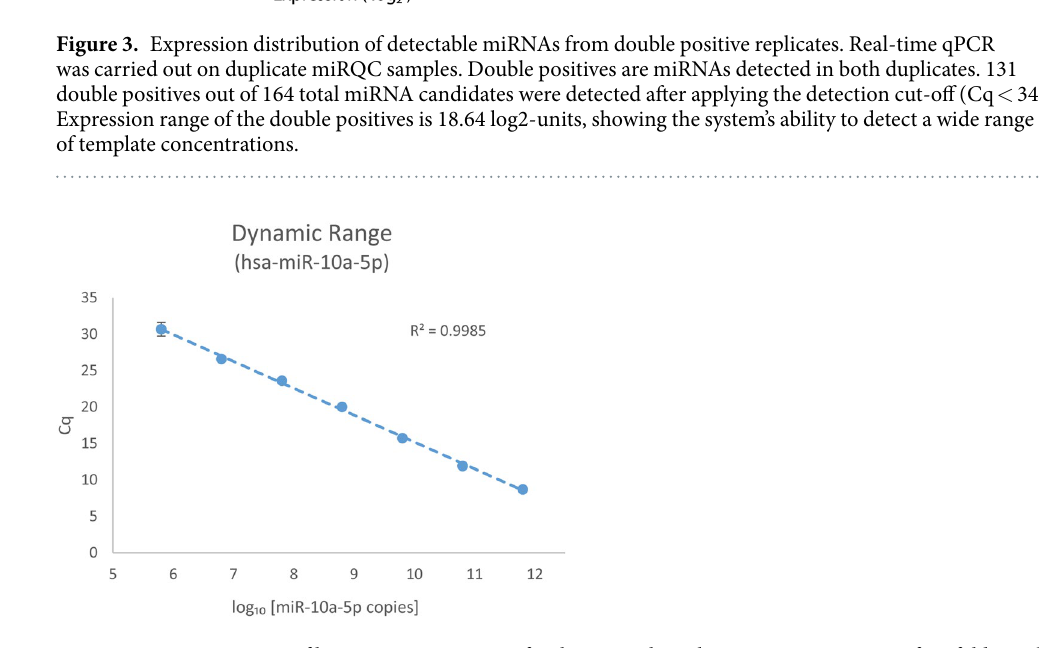
Figure 4. Dynamic range of known concentration of spike-in synthetic has-miR-10a-5p. A set of 10-fold serial dilutions of synthetic hsa-miR-10a-5p miRNA were spiked into the same amount of Universal Human miRNA reference RNA (samples 16–22, miRQC A) to generate cDNA for qPCR analysis. 20 ng of the RNA input was used for the spike-in test. qPCR results illustrated a dynamic range of at least 7 orders of magnitude ranging from 80 to 8 × 10 7 copies per